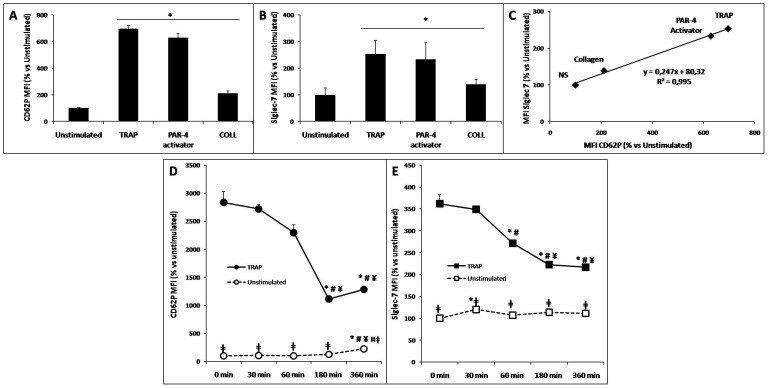
Characterization of Siglec-7 as a novel marker of platelet activation.(A),(C). Agonist-induced platelet activation (n = 10). Platelets were stimulated with different agonists: TRAP (PAR-1), PAR-4 activator, collagen (β2α1 integrin and GPVI-FcR gamma). Membrane MFI expression of CD62P (A) and Siglec-7 (B) was correlated under all experimental conditions (PCC = 0.995, p = 0.002) (C). (D),(E). Kinetics of CD62P (D) and Siglec-7 (E) expression on platelet membranes (n = 5). Membrane expression of Siglec-7 and CD62P in platelets under un-stimulated and TRAP stimulated conditions was analyzed by flow cytometry. MFI changes between CD62P and Siglec-7 were correlated over time (unstimulated: PCC = 0.842; p = 0.016; stimulated by TRAP: PCC = 0.958; p = 0.01). *, #, ¥, ¤: significant differences (analysis of variance, p<0.05) between MFI of Siglec-7 or CD62P marker over time vs 0, 30, 60, and 180 min respectively; ‡: t-test, p<0.05) MFI of Siglec-7 or CD62P marker in TRAP-induced platelets activation vs resting platelets (expression of CD62P and Siglec-7 in MFI was reported for unstimulated conditions at 0 min, which was considered as 100%).